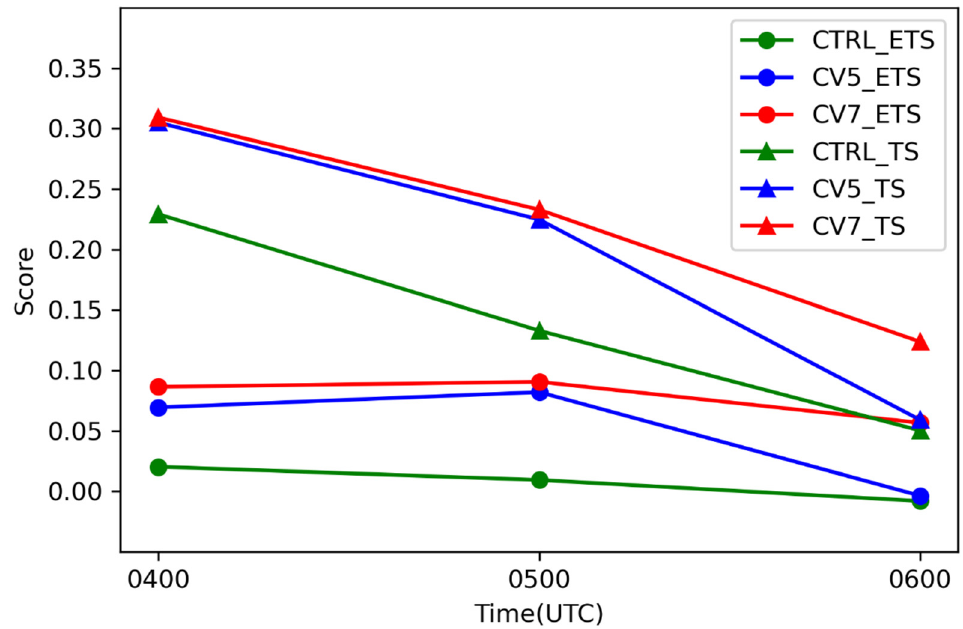
Figure 10. ETSs and TSs of composite reflectivity from 0400 UTC to 0600 UTC at the 30 dBZ thresholds for three experiments (CTRL: green line, ψ − χ control variable: blue line, U − V control variable: red line).